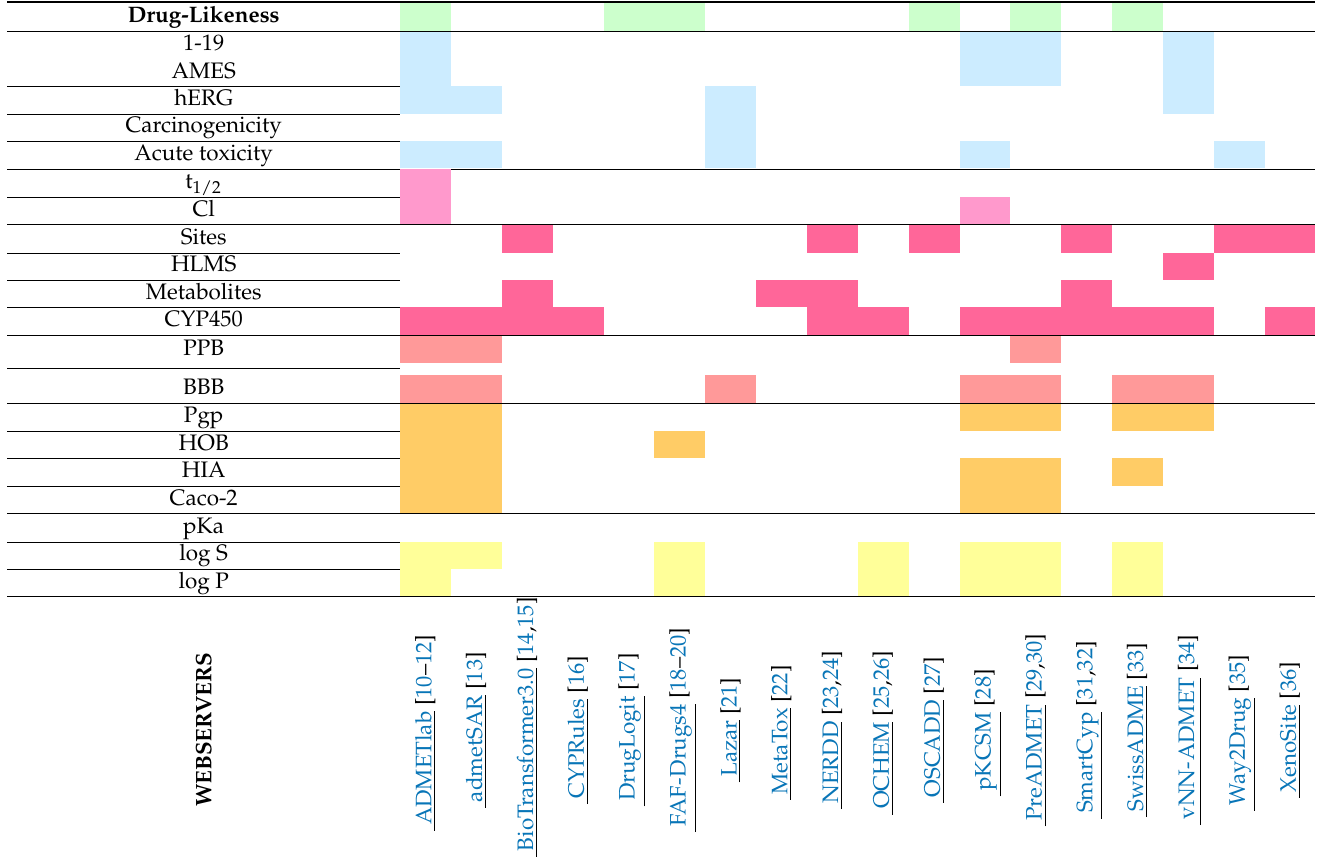
Table 2. Free web servers used for the prediction of ADMET